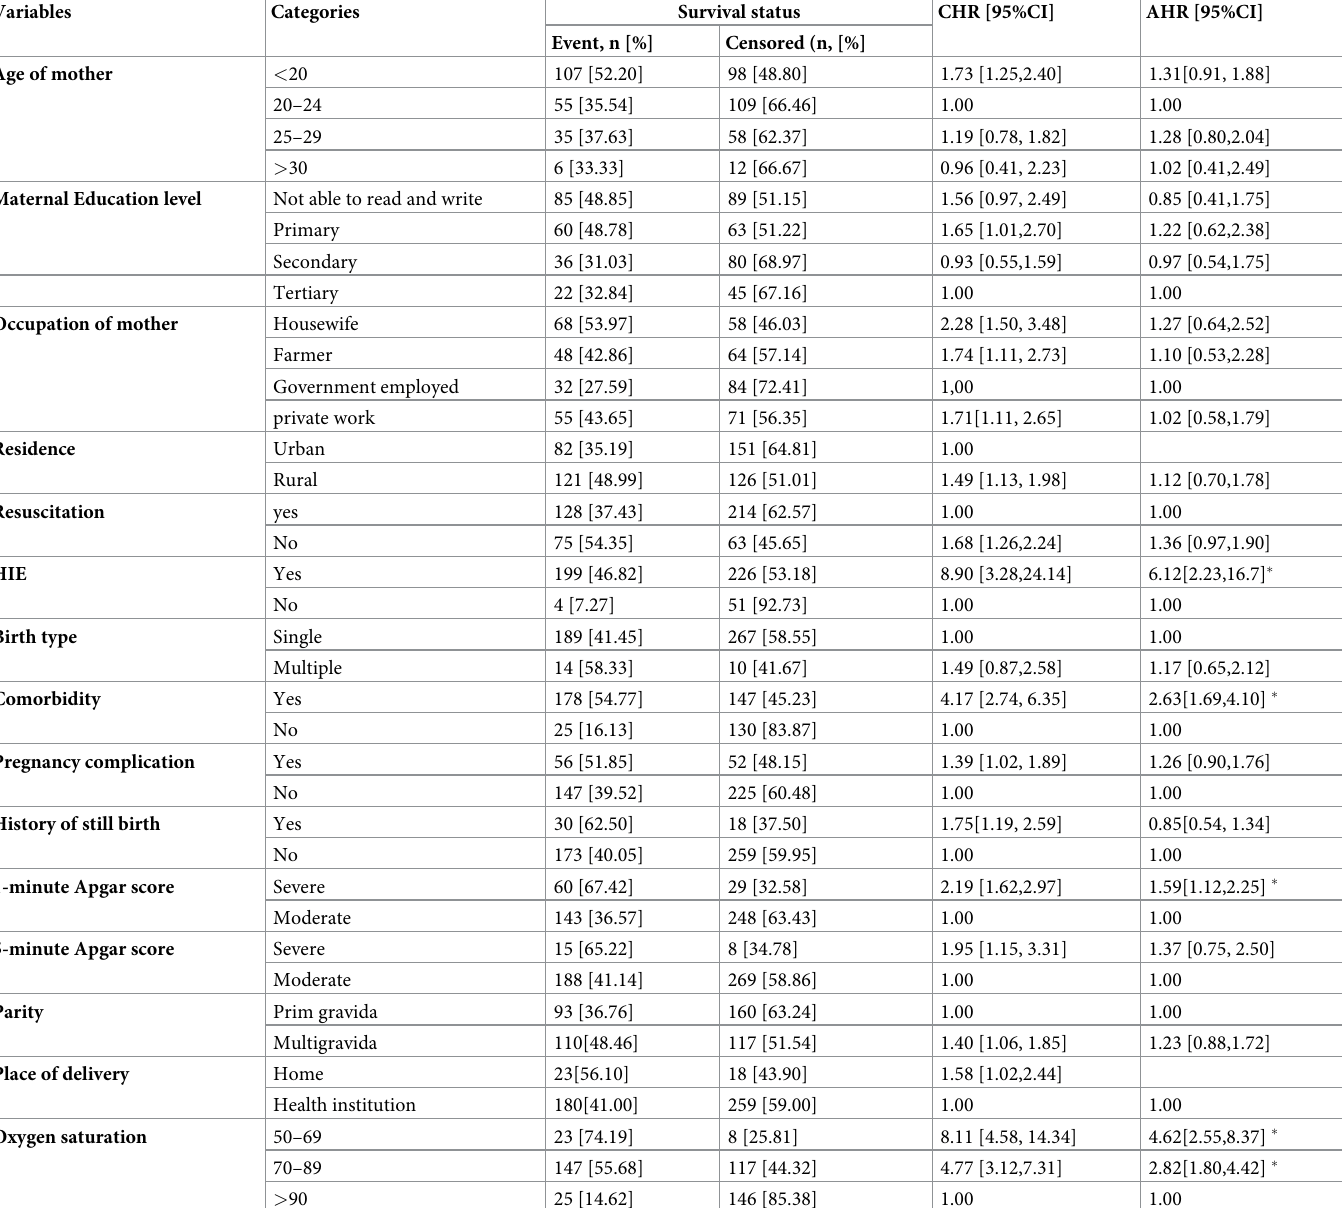
Table 3. Bivariable and multivariable Cox regression analysis of the risk of neonatal mortality among asphyxiated neonates in Northwest Ethiopia selected hospitals from November 1, 2018, to November 1, 2019. Variables